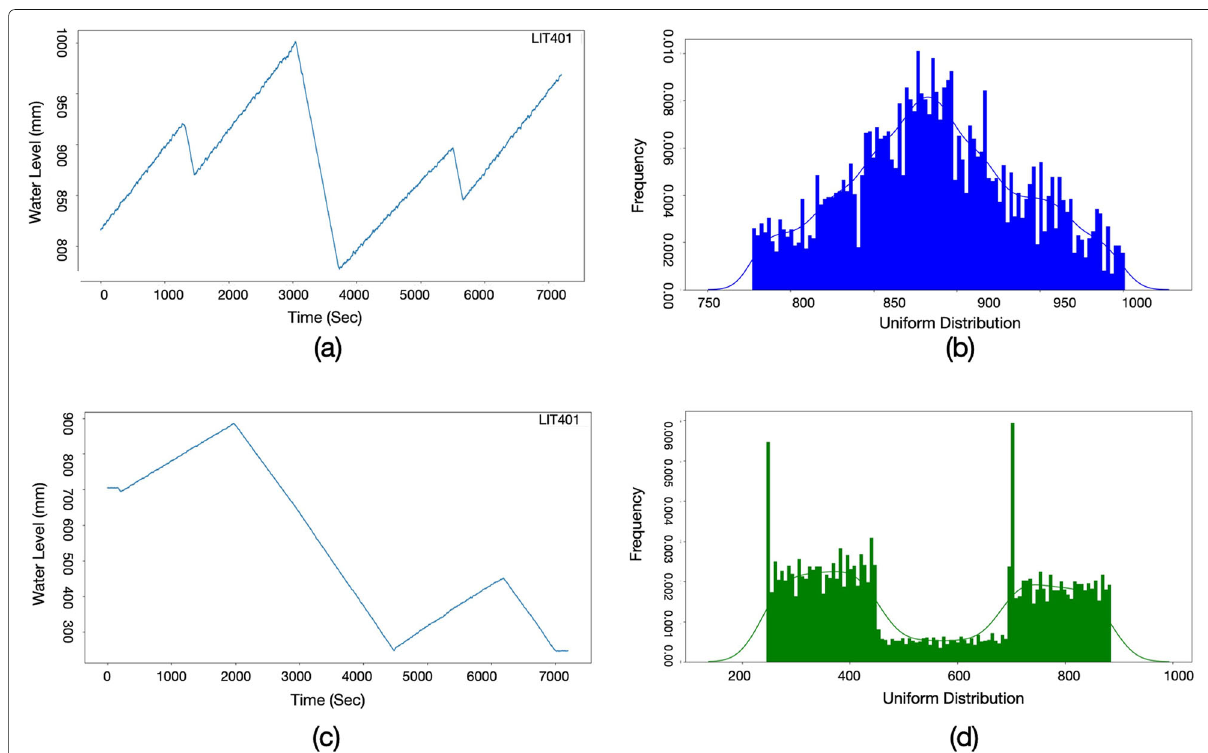
Fig. 4 Comparison of feature statistics: a Behavior of LIT401 in 2015; b normal distribution plot of a with mean=0.42 and variance= 0.248; c behaviour of LIT401 in CISS2020-OL event; d normal distribution plot of c with mean=0.53 and variance=0.37; P -value of K-S test (Karson 1968) is